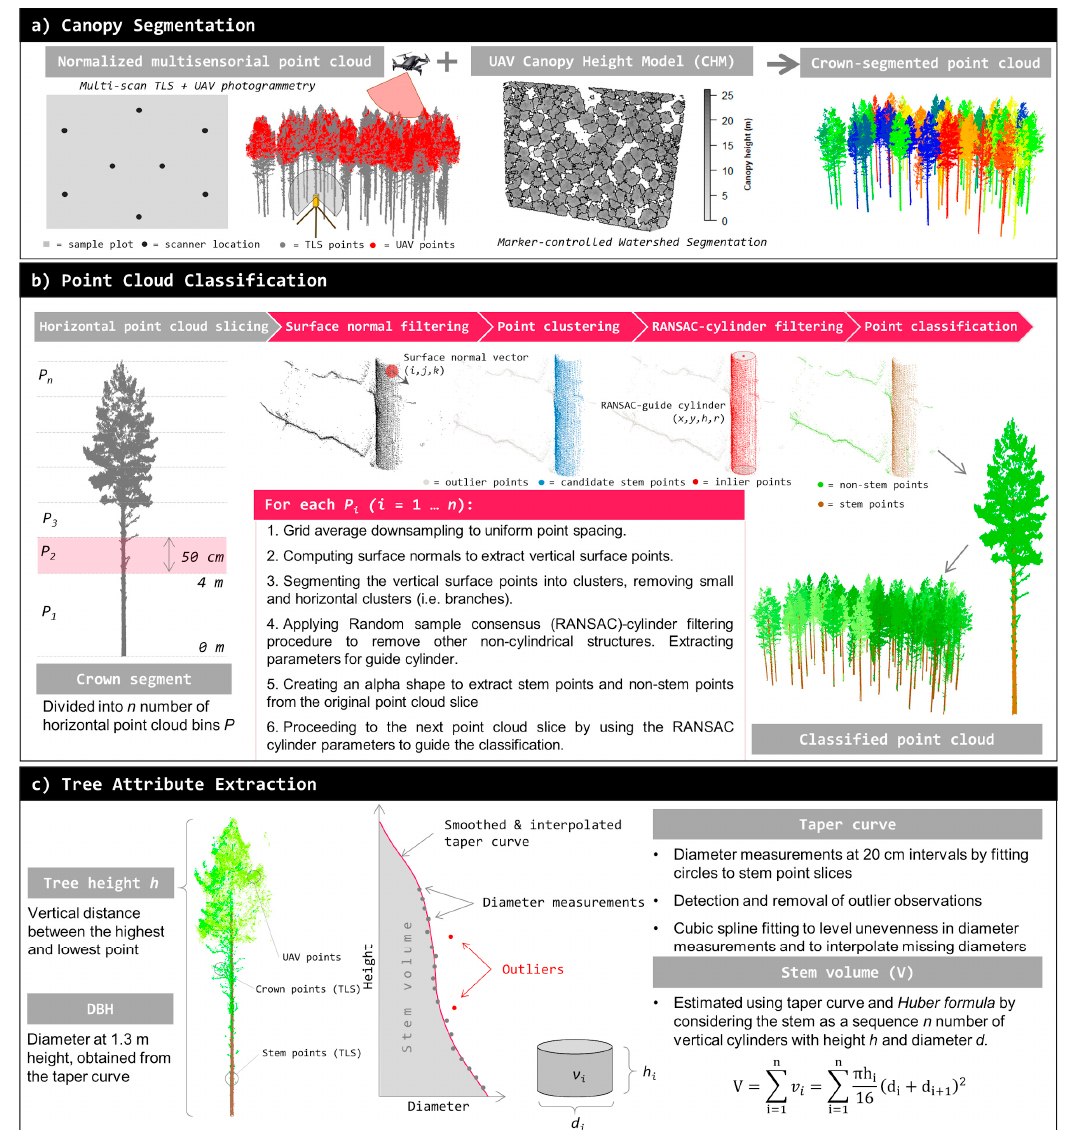
Figure 3. Outline of the point cloud processing method: ( a ) canopy segmentation, ( b ) point cloud classification, and ( c ) tree attribute extraction.